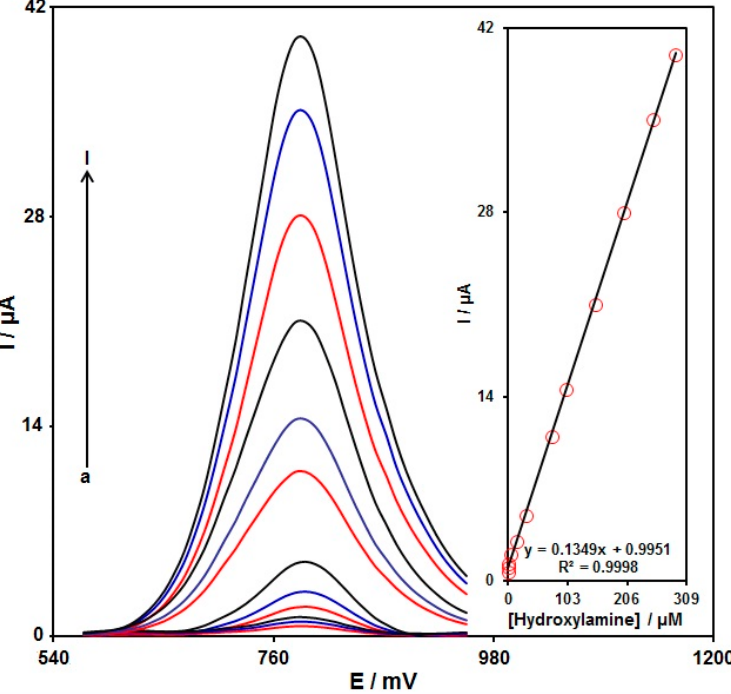
Figure 9. DPVs recorded for the PPy NTs/GSPE in 0.1 M (pH 7.0) with variable hydroxylamine concentrations. Nos. a–I: 0.005, 0.07, 1.0, 5.0, 15.0, 30.0, 75.0, 100.0, 150.0, 200.0, 250.0, and 290.0 μ M of hydroxylamine. Inset: Plot of the electrocatalytic peak current as a function of the variable hydroxylamine concentrations (0.005–290.0 μ M). Table 1. Comparing the analytical performance of the PPy NTs/GSPE with other modified elec- trodes used for hydroxylamine determination.